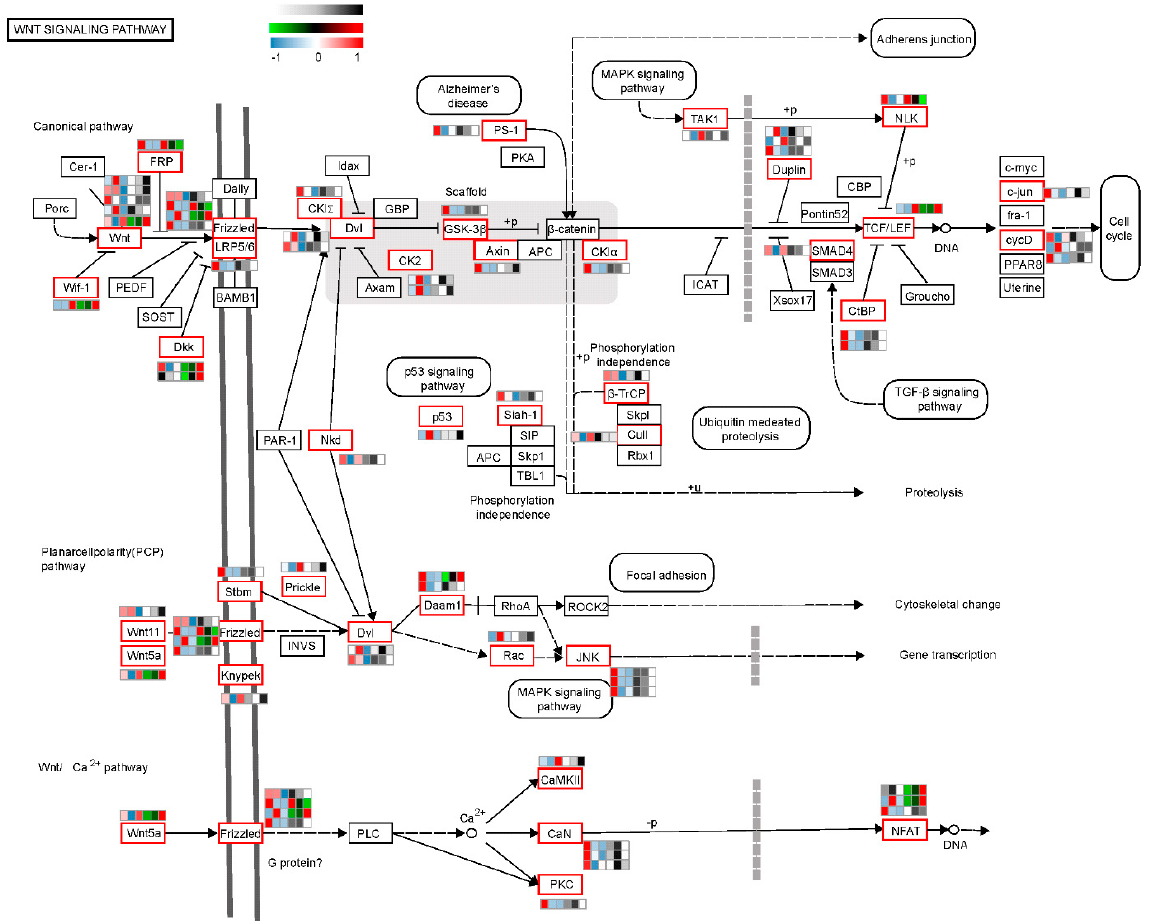
Figure 7. Heatmap of Wnt members at the level of transcription and translation based on the Wnt signaling pathway (ko04310) network map. The genes displayed in the Wnt metabolic pathway heatmap that were differentially expressed in any of the three comparison groups at the transcription level, or differentially expressed genes in any of the three comparison groups at the translational level, are displayed on the heat map. There were a total of 58 genes in the Wnt metabolic pathway heatmap, for which the gene heatmap of the translatome is the three shades on the left and the gene heatmap of the transcriptome is the three shades on the right; heat map homogenization used Zscore. First, if a gene was only differentially expressed at the transcription level, it is displayed in red, black, and green shades at the transcription level and black, gray, and white shades at the translation level. Second, if a gene was only differentially expressed at translation level, it is displayed in red, white, and blue shades at the translation level and black, gray, and white shades at the transcription level. Third, if a gene was differentially expressed at both the transcription and translation levels, it is displayed in red, black, and green shades at transcription level and red, white, and blue shades at translation level.